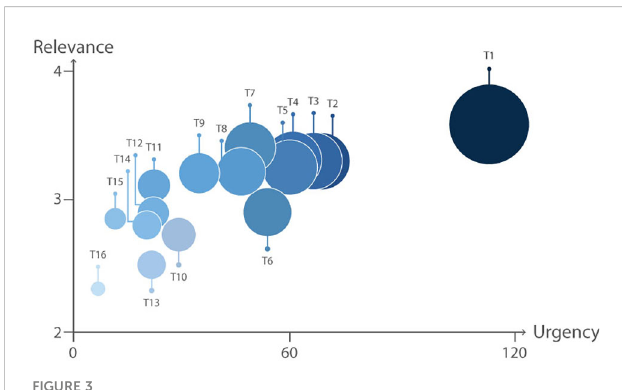
FIGURE 3 Topics by relevance and urgency level. Relevance: “ Very relevant ” : [4.00;3.00> and “ relevant ” : [3.00:2.00>. Urgency is measured as the score assigned by respondents surveyed. Circle diameter = relevance x urgency. The topics are provided in Table